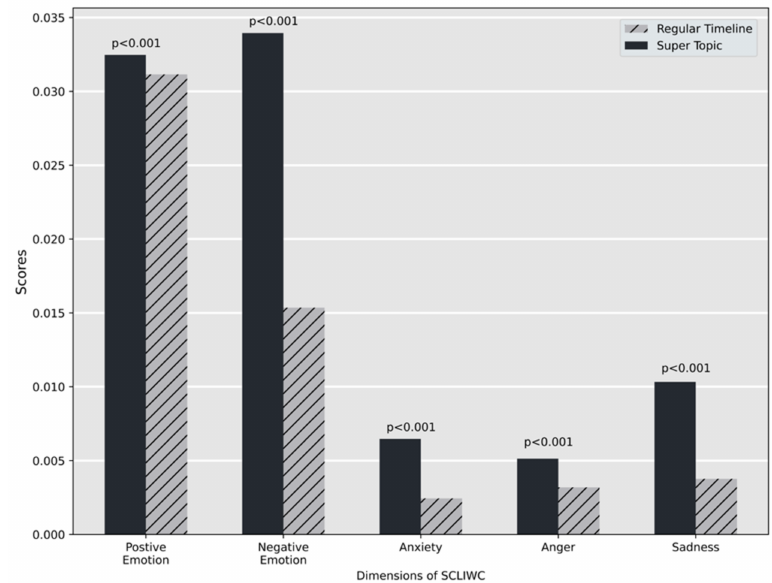
Figure 2. SCLIWC scores for selected